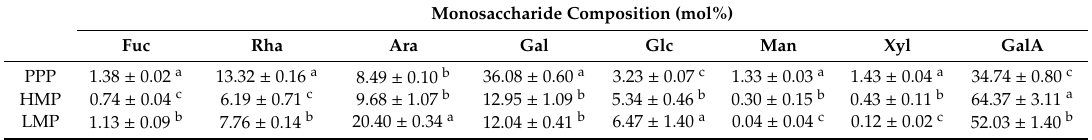
Table 2. Molar ratio of monosaccharides in PPP, HMP and LMP 1